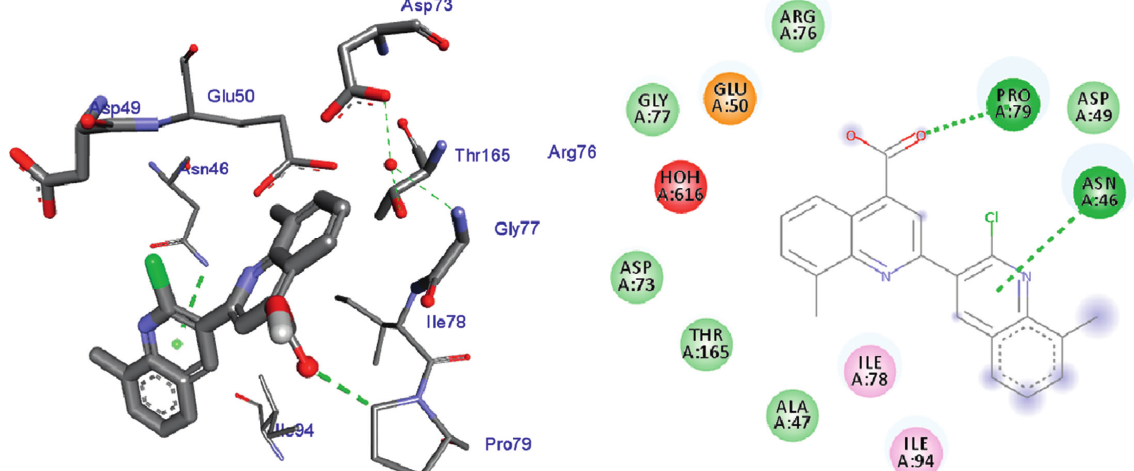
Figure 4: The binding interactions of 7 against E. coli DNA gyrase A (PDB ID :6F86).